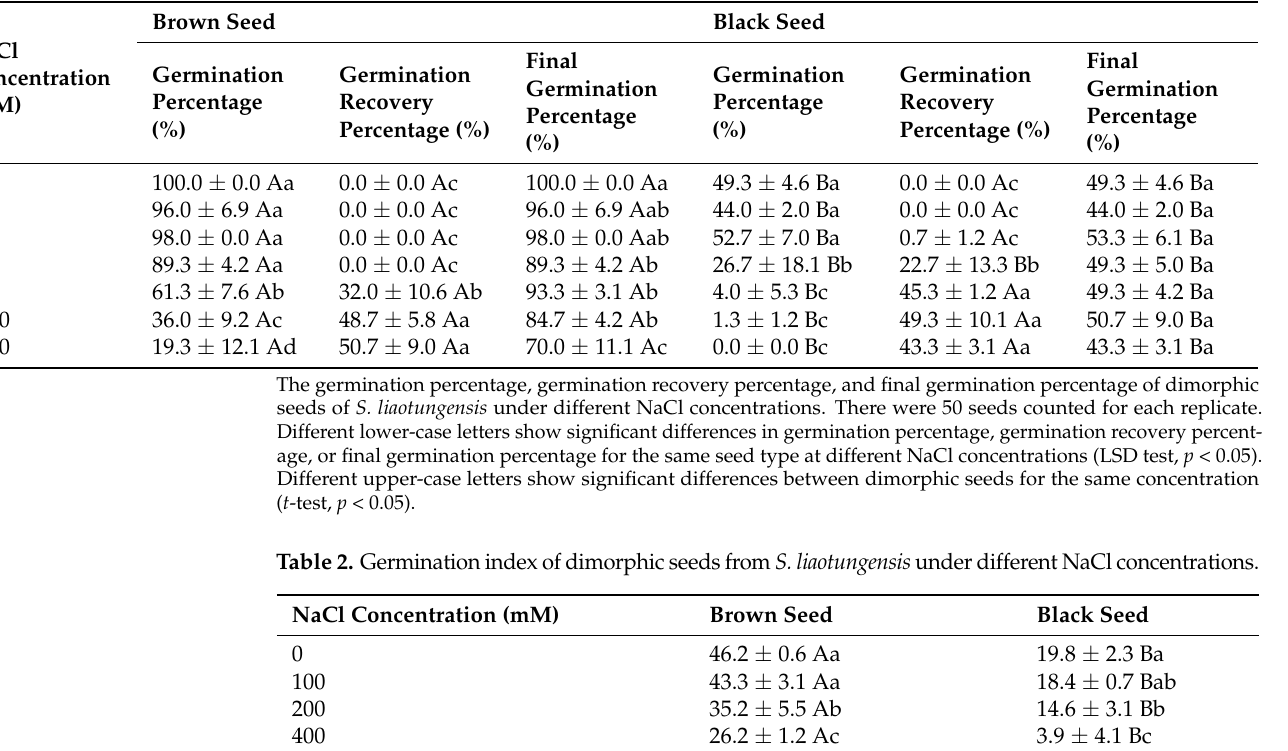
Table 1. Effect of NaCl on germination of dimorphic seeds of S. liaotungensis .